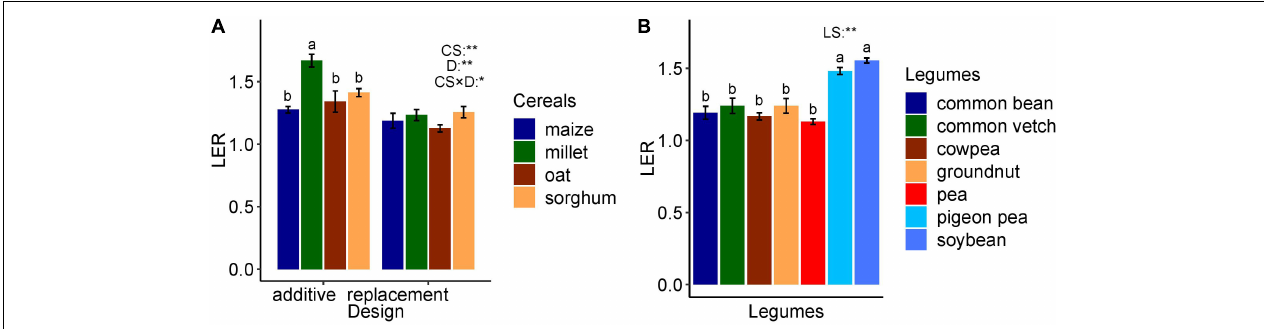
FIGURE 4 | (A) Effect of cereal species and design on LER. (B) Effect of legume species on LER. The letters show the statistical differences between species. CS, cereals species; D, design; CS × D, species interaction with design; LS, legumes species; *significant ( p < 0.05), **highly significant ( p < 0.01), and the error bar is the standard error of the mean. The two designs (additive and replacement) are not represented for legumes because the effect of design is not significant.